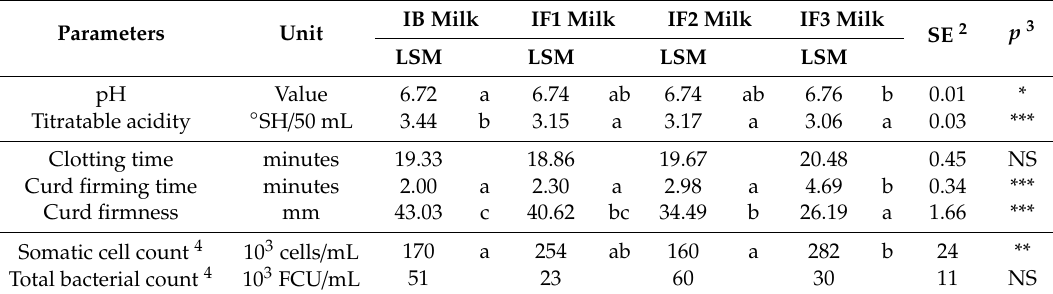
Table 3. Least square mean (LSM) values of pH, titratable acidy, rennet coagulation parameters, somatic cell count and total bacteria count of vat milk from Italian Brown (IB milk) or Italian Friesian (IF1, IF2, IF3 milk) cattle herds used in 12 Parmigiano Reggiano cheese-making trials 1 .